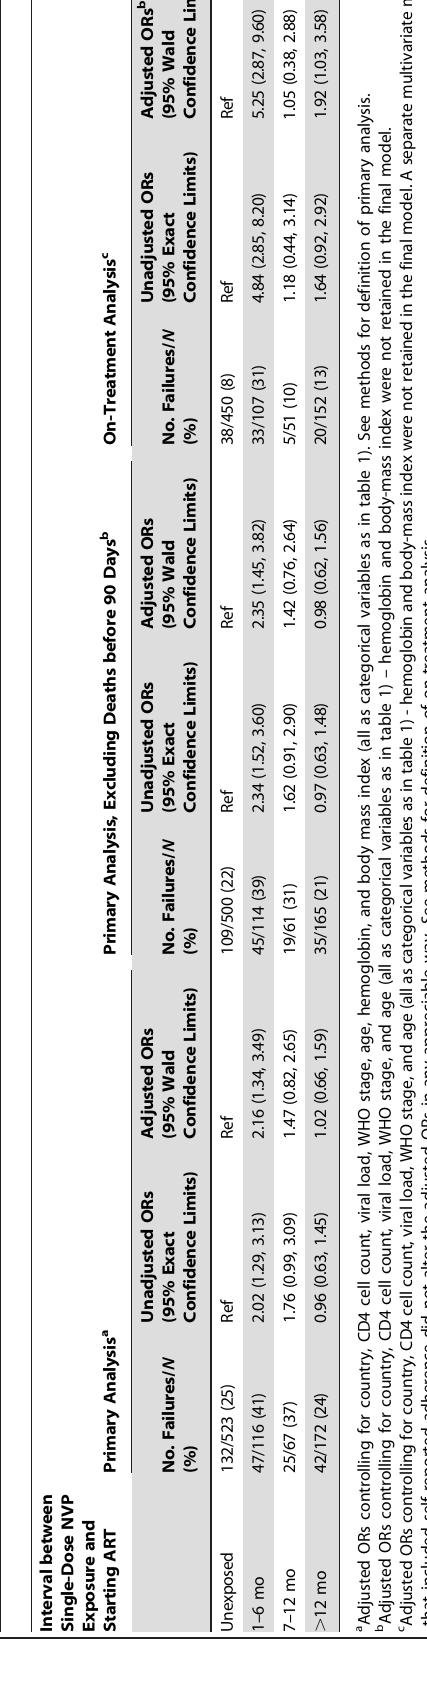
Table 3. Factors associated with treatment failure in the primary analysis in the NNRTI Response Study—Zambia, Kenya, Thailand (2005–2008).